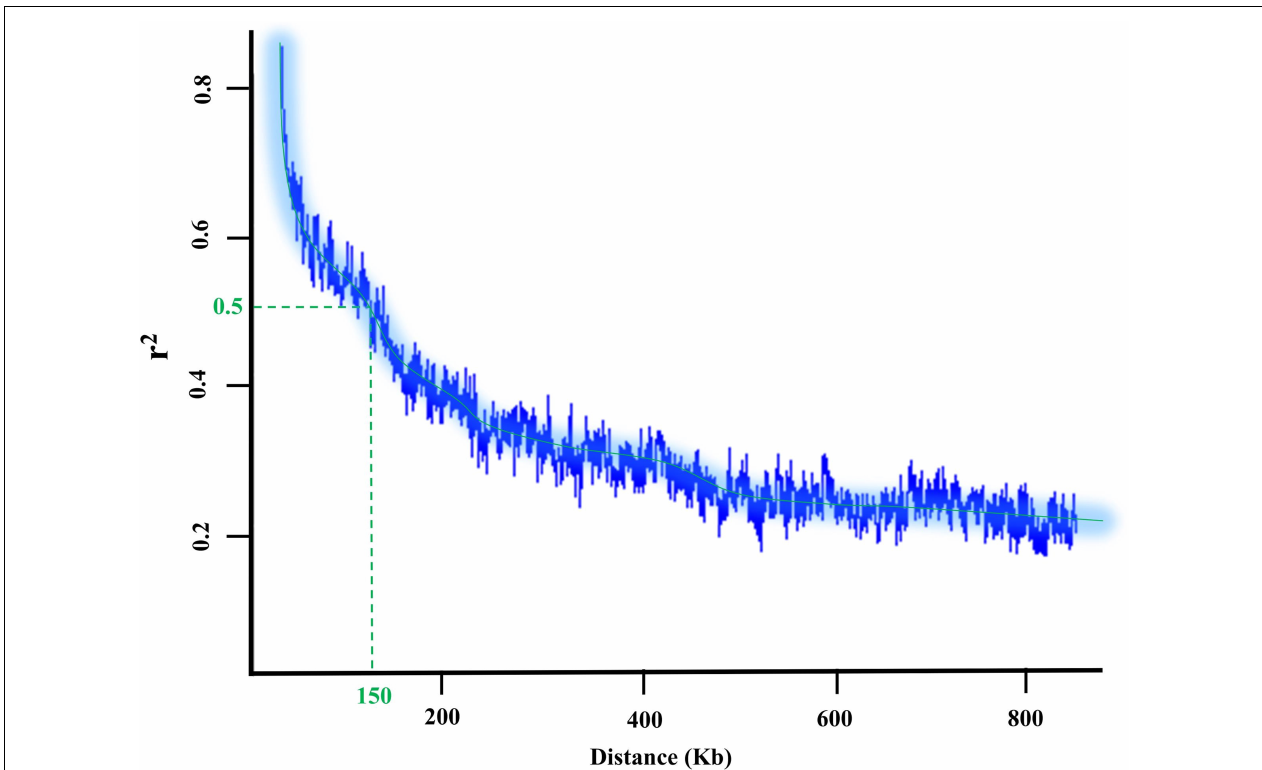
FIGURE 1 | LD decay plot and the flanking regions of each detected SNP in 227 soybean